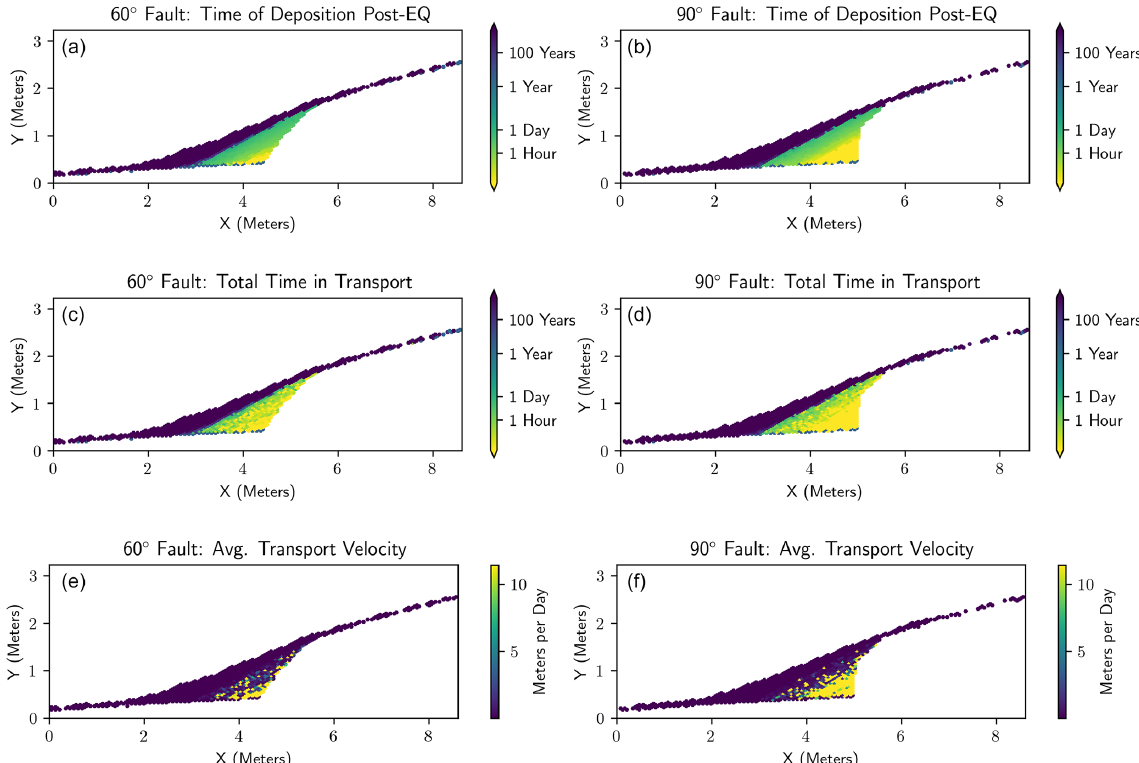
Figure 7. Illustration of the timescales and rates of mobile regolith cell transport. See the Supplement for plots from the full parameter space. (a, b) Plots of the time of deposition following the scarp-forming earthquake. (c, d) The total time a mobile regolith cell spends in transport before coming to rest and burial. For both the 60 ◦ (a) and 90 ◦ faults (b) , the colluvial wedge appears to have mostly developed within 1–10 model years. Some model runs with high relative collapse rates can produce a rapid initial deposit within hours to days. This rapid initial deposit is buried relatively slowly over hundreds of years until the modeled colluvial wedge reaches its maximum volume. (e, f) The average velocity of transport, calculated as the linear distance (a, b) divided by the total transport time (c, d) . The higher average velocity indicates that the cell has traveled a significant distance in a relatively short period of time (e.g., gravitational free fall) compared to those that travel similar or shorter distances over a longer period of time (e.g., mobile regolith creep). Note the higher number of high-velocity cells in the 90 ◦ versus the 60 ◦